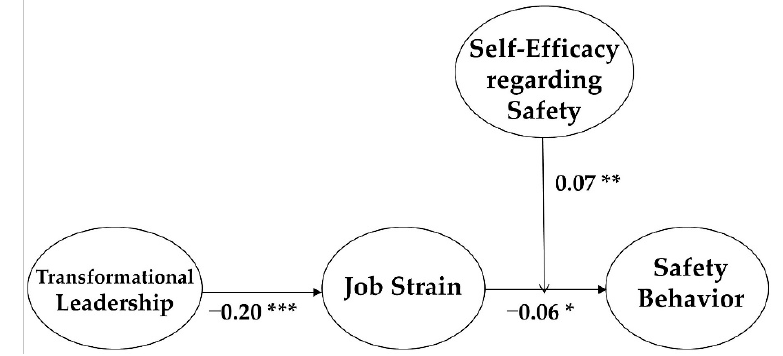
Figure 2. The standardized estimate values of the final model. Notes: * p < 0.05, ** p < 0.01, *** p < 0.001.